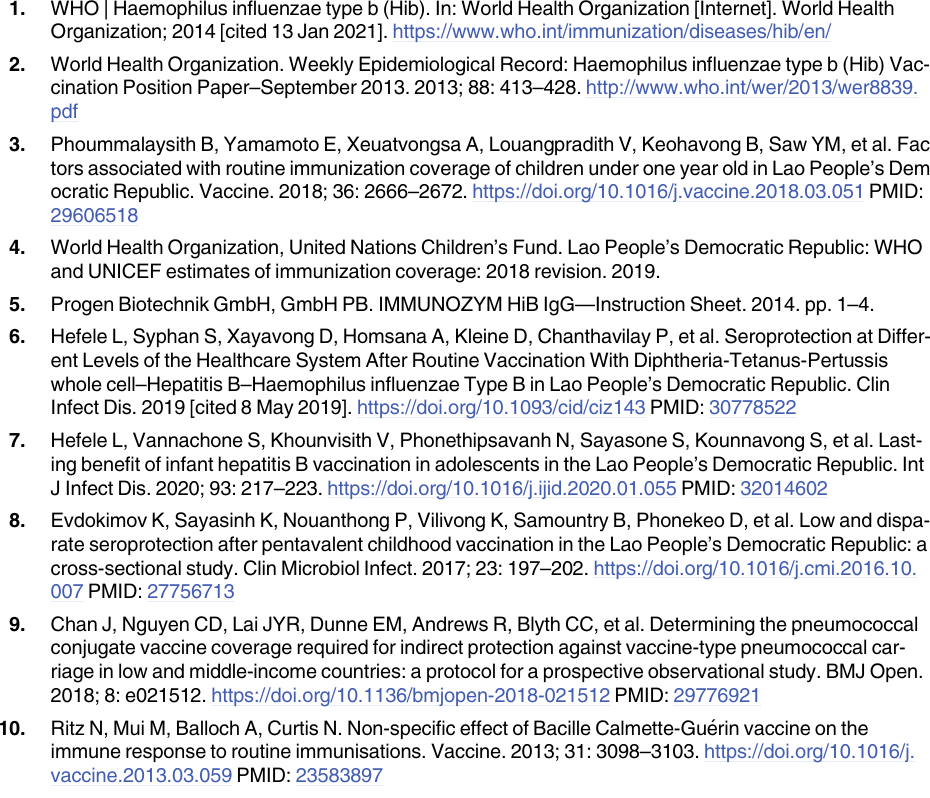
S1 Table. Anti-Hib IgG prevalence according to participants’ characteristics for each study